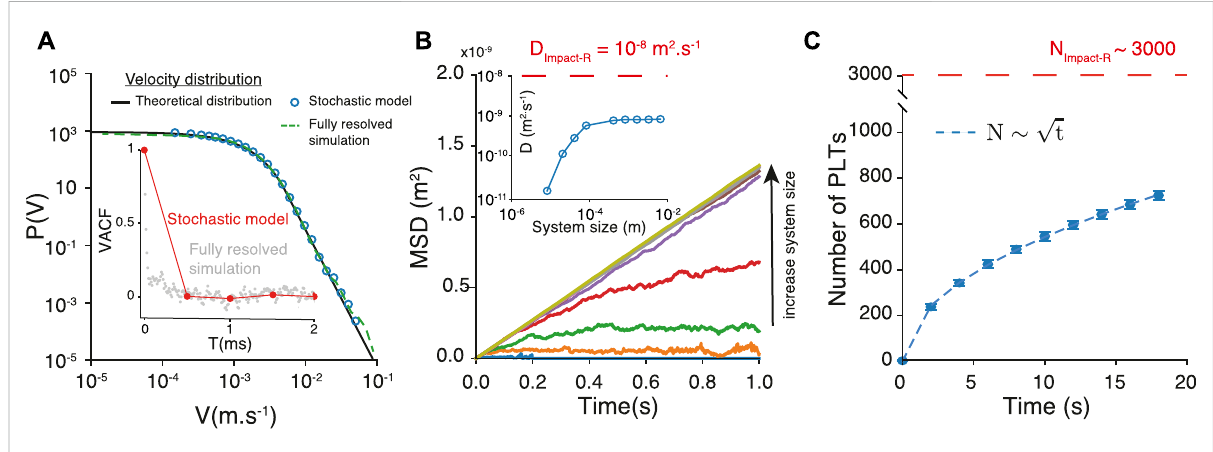
FIGURE 4 (A) Velocity probability distribution obtained from the fully resolved simulation, the analytical expression and the stochastic model. (B) Mean square displacement obtained with the stochastic model of trajectories, for different system sizes. The inset show of the corresponding diffusion coef fi cient is sensitive to the size of the system, for small systems. The red dashed line represents the diffusion coef fi cient estimated from the Impact-R experiments. (C) The number N of platelets that deposit as a function of time for a system of size L = 0.82 mm and initially 4,800 platelets uniformly distributed along L . The red dashed line represented the number of deposited platelets measured on the Impact-R device.